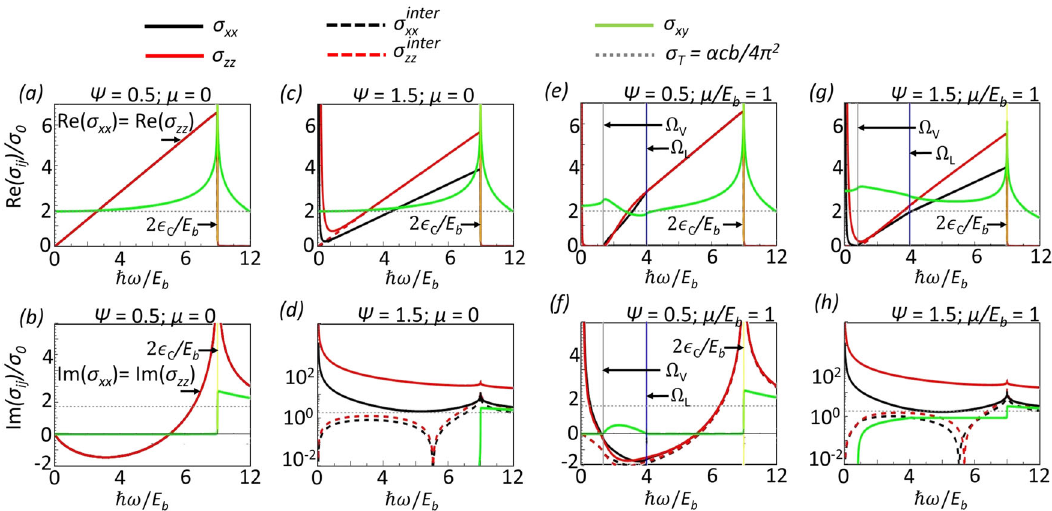
Fig. 2 Conductivity tensor components for type I and II Weyl semimetals at zero temperature and real frequencies. Real and Imaginary parts of different conductivity tensor components for a single Weyl cone scaled by σ 0 ¼ α c as a function of frequency scaled by E b = ℏ v F b for: a , b Ψ = 0.5, μ = 0; c , d Ψ = 16 π v F 1.5, μ = 0; e , f Ψ = 0.5, μ / E b = 1; g , h Ψ = 1.5, μ / E b = 1. The legend given above the panels denotes the total σ xx,b (full black) and σ zz,b (full red),